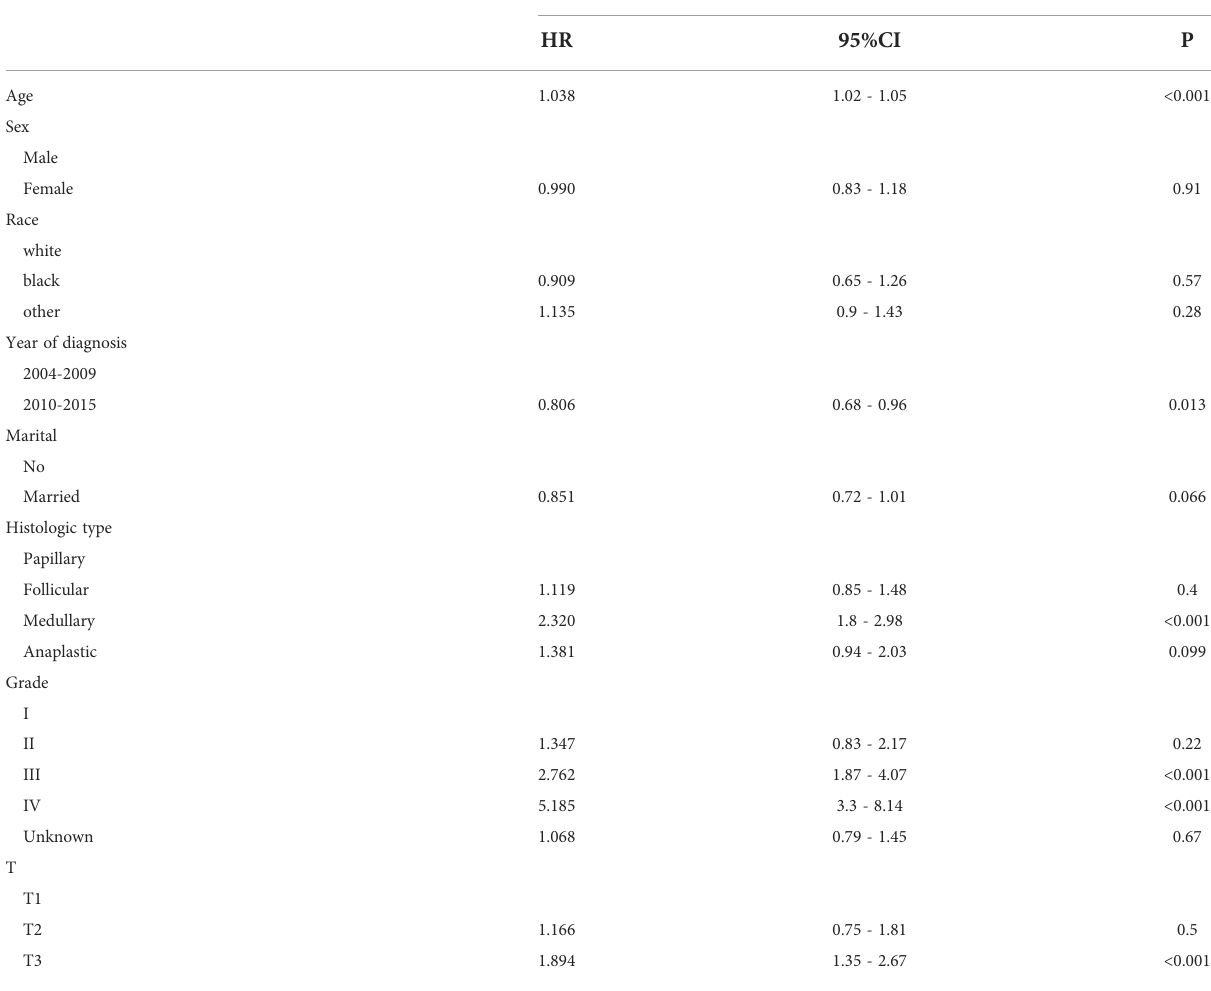
TABLE 3 Multivariate Cox regression models predict cancer-speci fi c mortality in elderly patients with thyroid